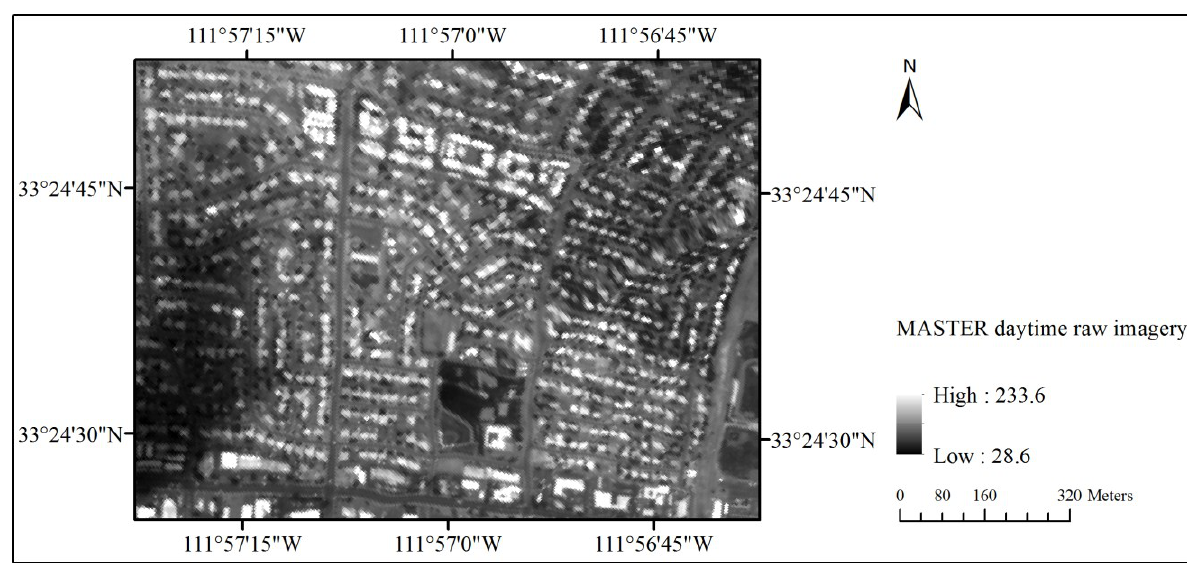
Figure 2. Airborne LIDAR point clouds.